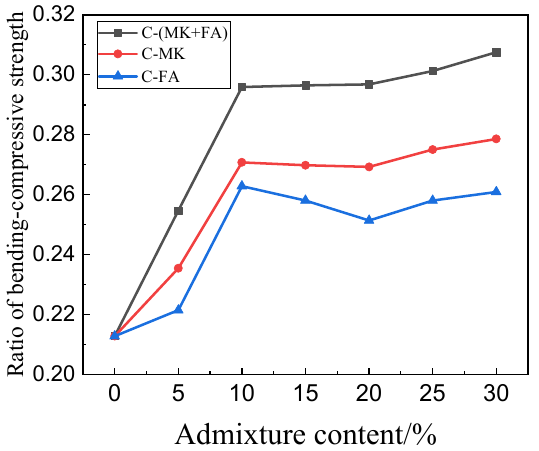
Figure 5. Flexural strength of hardened MOSC after different curing durations: ( a ) 3 days; ( b ) 28 days.